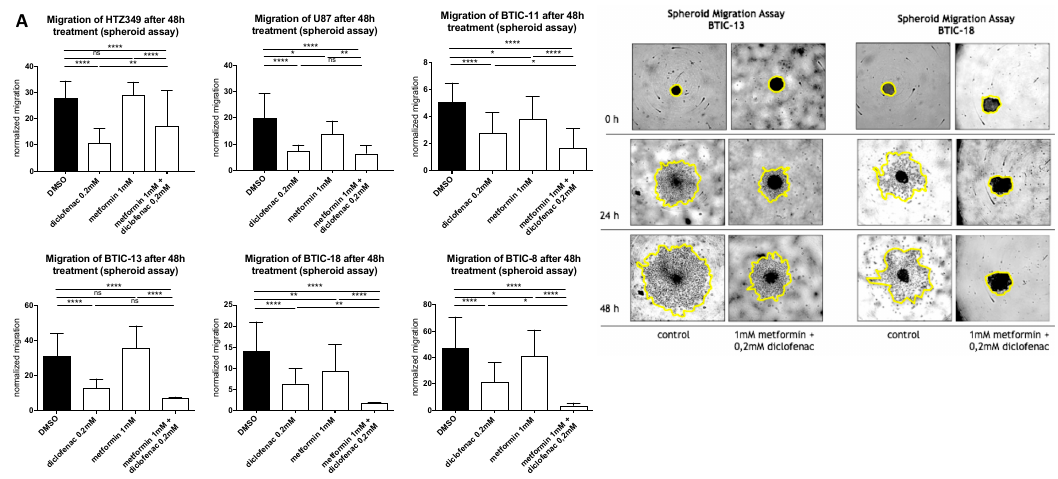
Figure 2. ( A,B ) Spheroid assays were used to analyze the anti-migratory effects at a 48-h time point. Results are expressed as mean ± SD and were analyzed by two-way ANOVA, p = 0.0332 (*), p = 0.0021 (**), p = 0.0002 (***), and p ≤ 0.0001 (****) compared pairwise, i.e., the metformin-treated versus metformin and diclofenac condition. Table 1. Combination index (CI) using CompuSyn software. Thereby, CI < 1 indicates synergistic effects, CI = 1 additive effects, and CI > 1 antagonistic effects.